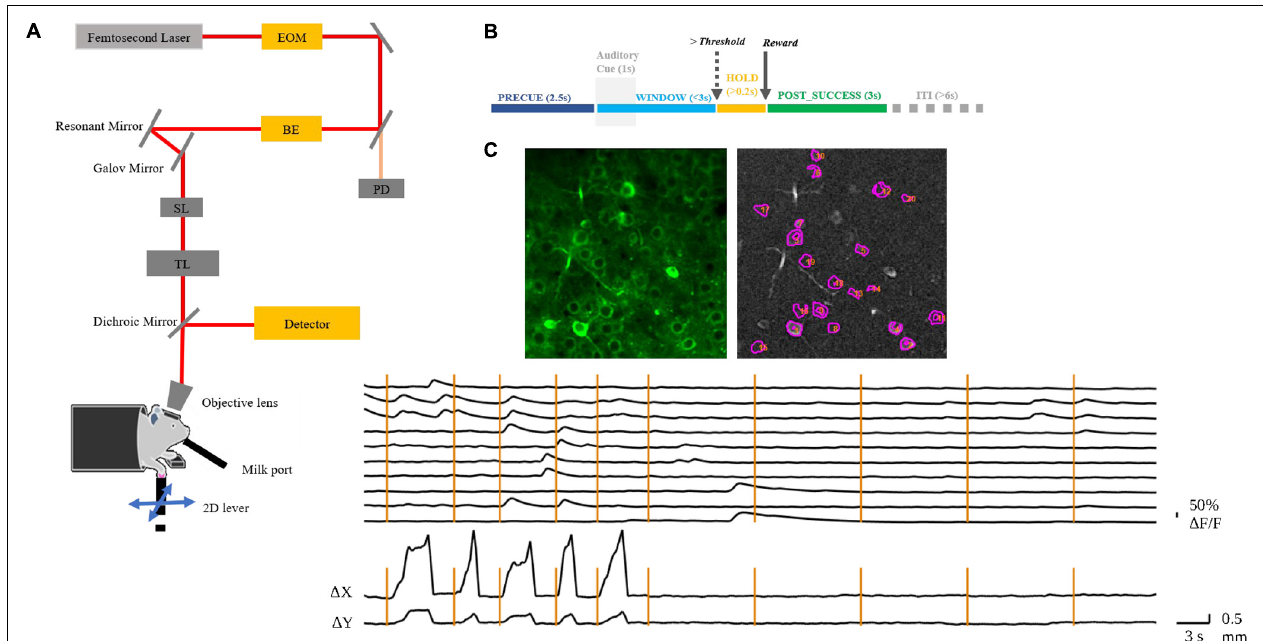
FIGURE 1 | ( A ) Layout of the custom-built TPM. EOM, electro-optic modulator; BE, beam expander; SL, scan lens; TL, tube lens. The mouse with craniotomy was head-fixed under the objective. ( B ) Behavior experiment schema. The mouse was required to hold the lever for 2.5 s to initiate an auditory cue. After the presentation of the auditory cue, the mouse could move the lever in any direction and would receive a chocolate milk reward when the reaching movement exceeded a preset threshold distance from the initial position. The WINDOW for mouse to complete the task was 3 s. If successful, the state was preemptively changed to POST_SUCCESS for reward. ( C ) A representative image of the left RFA with identified neurons in motor cortex layer 2/3 of mouse 9L (top); the normalized (cid:49) F / F of the numbered neurons and the corresponding lever trajectory indicated as (cid:49) x and (cid:49) y (bottom). The vertical lines indicate the auditory cue of each